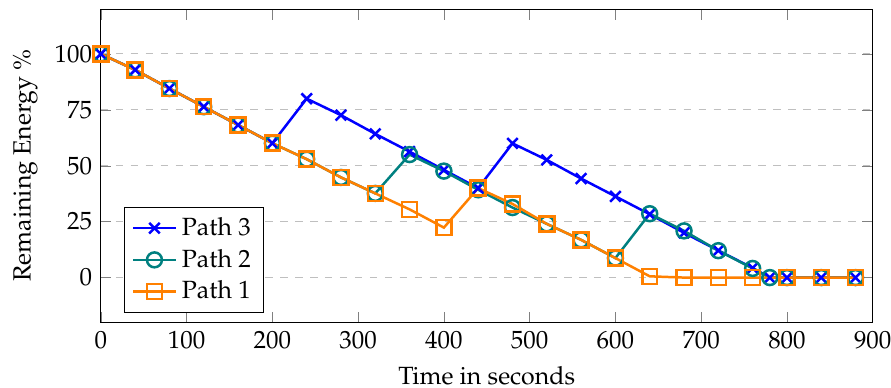
Figure 7. UAV’s remaining energy when the UAV becomes malicious with respect to